Question: In a single sentence, describe what this figure presents.
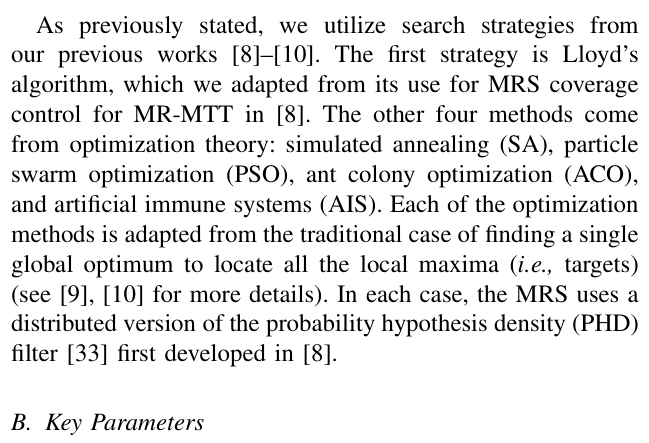
Answer: shows the steady-steady OSPA (i.e., error) for different numbers of robots search for 50 static targets. We can see a consistent trend across all search methods: as the number of robots increases, the final OSPA value decreases, signifying enhanced tracking performance due to the larger robot team. Interestingly, once the number of robots surpasses the number of targets, the OSPA value tends to plateau, indicating minimal or no additional improvement. This plateau effect implies that, after a certain threshold, adding more robots does not substantially improve the accuracy of tracking static targets. Predicting the trend of system performance at steady state is relatively straightforward, especially when considering single variables. For instance, it is intuitive to assume that an increase in the number of robots or the size of their FoV enhances search and tracking capabilities. Conversely, an increase in the number of targets elevates the required search capacity. However, t